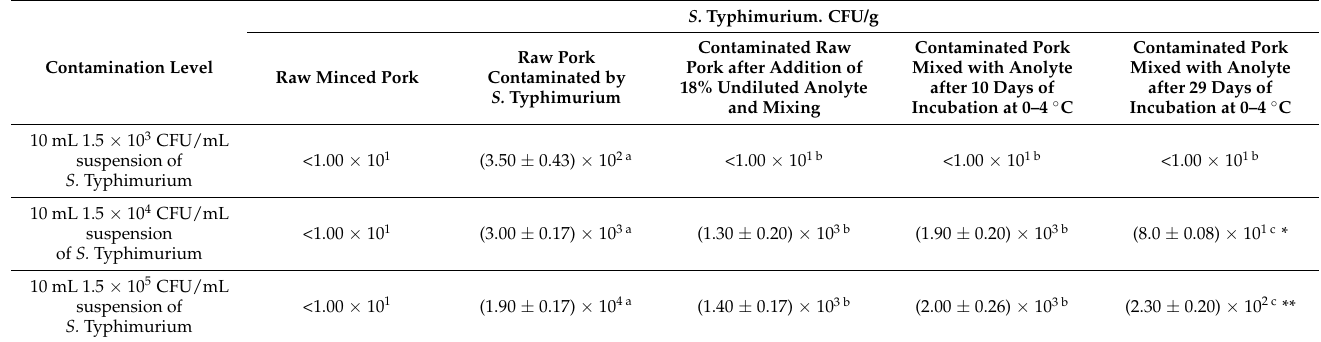
Table 8. Effect of anolyte on the S . Typhimurium count of minced pork contaminated by S. Typhimurium.